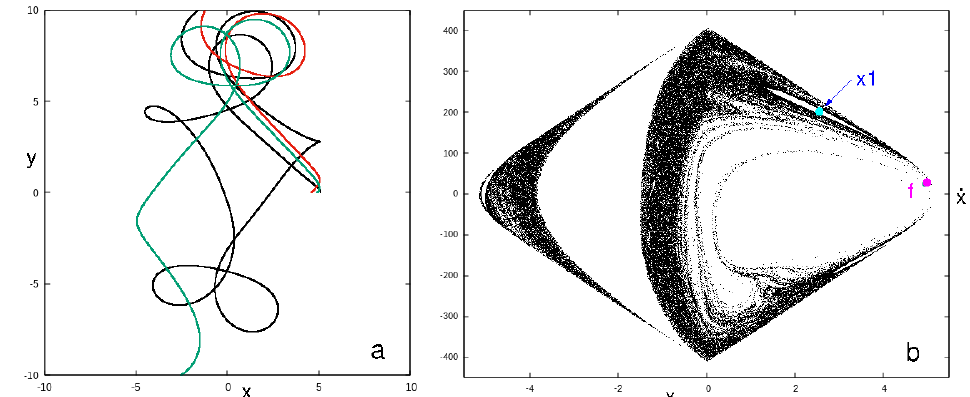
Figure 5. ( a ) Three orbits with loops, plotted with black, green and red color) that follow different ) = ( ± 1.21, ± 9.65 )) . ( b ) The central part paths and eventually cross the corotation region (( x L , y L 1,2 1,2 of the ( x , ˙ x ) surface of section at E J = − 111,723. The location of x1 and f are indicated with a green and magenta dot, respectively. The left empty part (roughly for x < − 0.5) is occupied by invariant curves around x4 (not plotted), while the empty part for x > − 0.5 is due to the fact that orbits with initial conditions in this region are practically escape orbits (they intersect the surface of section at large distances, outside the frame of panel).